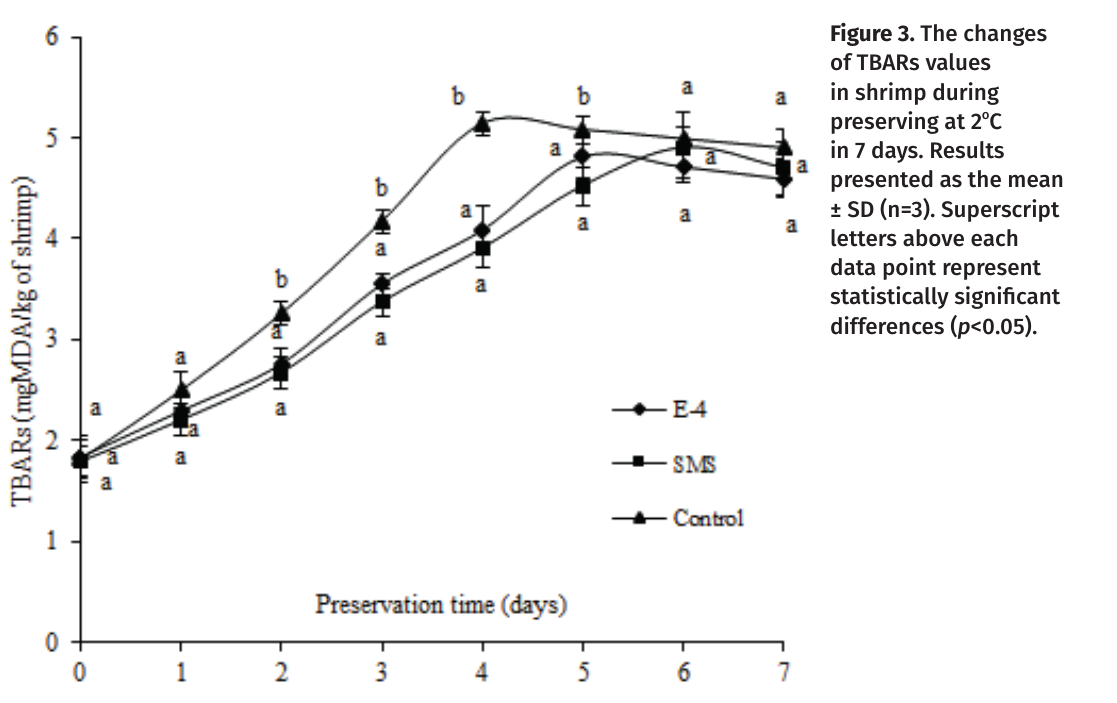
Figure 3. The changes of TBARs values in shrimp during preserving at 2 o C in 7 days. Results presented as the mean ± SD (n=3). Superscript letters above each data point represent statistically signifi cant differences ( p